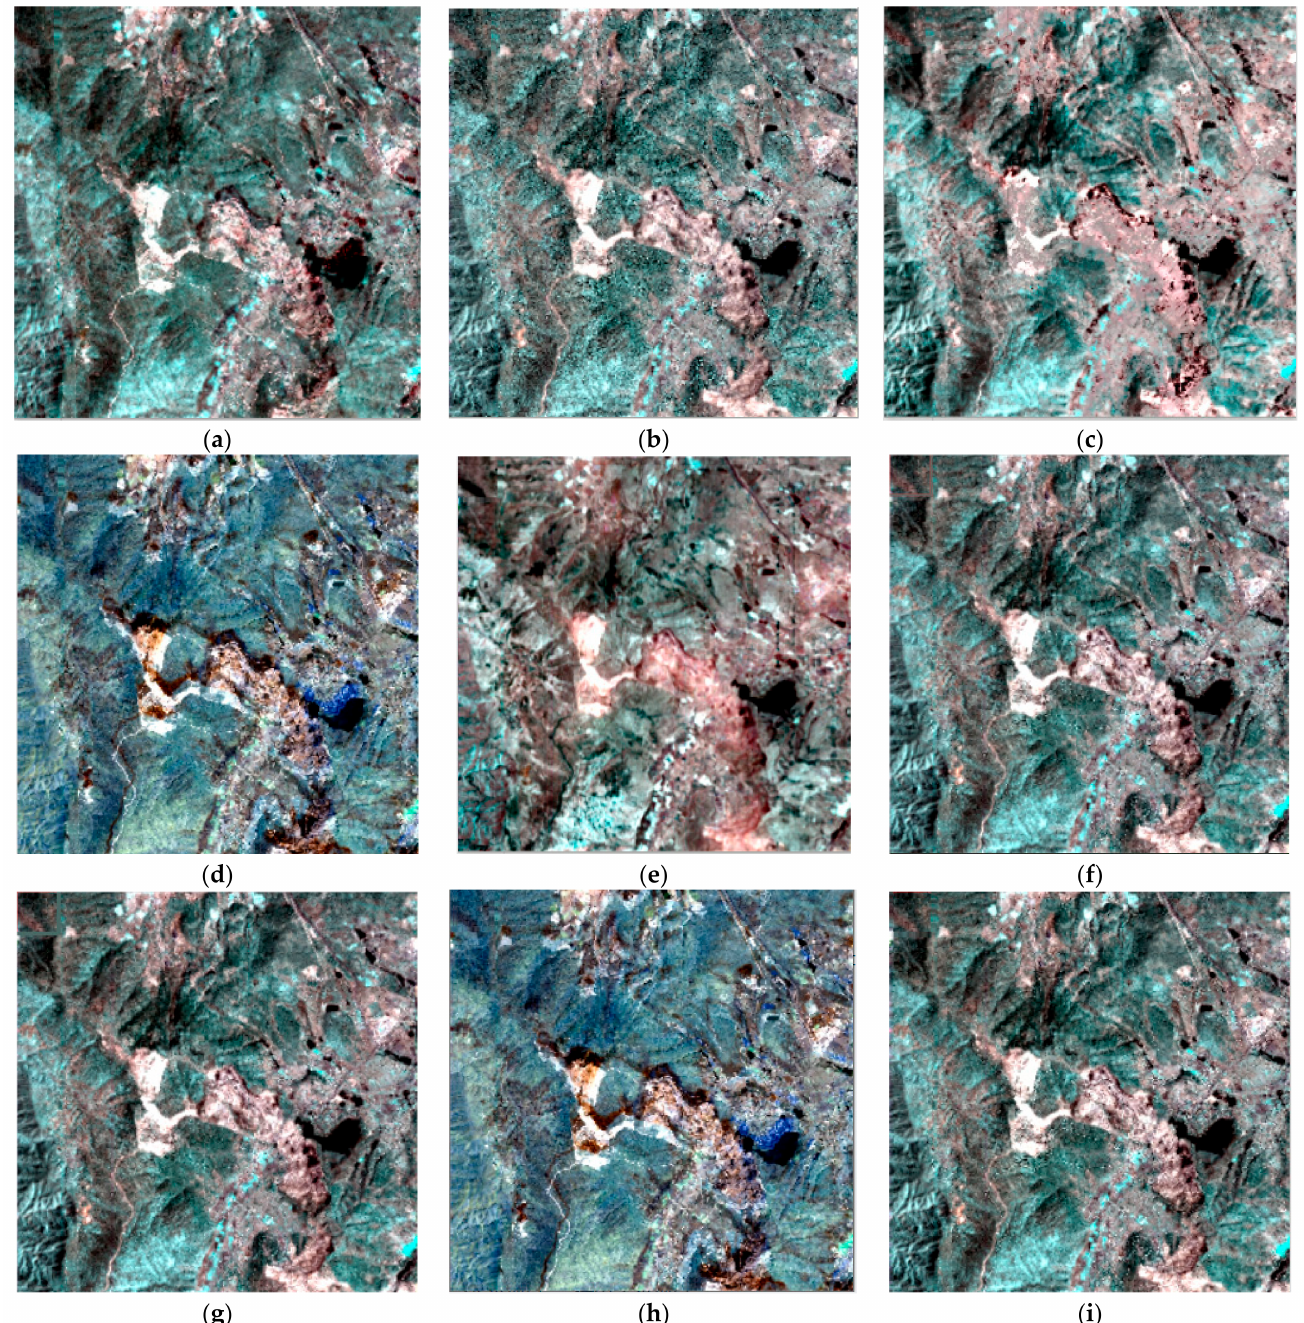
Figure 12. RGB images of ground truth, the different methods and the proposed EDRN method for the Dianchi dataset: ( a ) Ground truth, ( b ) AWLP, ( c ) CNMF, ( d ) GIHS, ( e ) MTF_GLP, ( f ) HPF, ( g ) SFIM, ( h ) DIP-HyperKite and ( i )